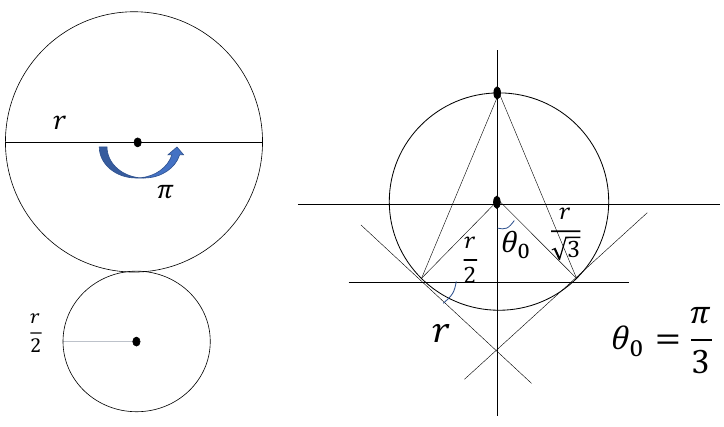
Figure 1 . The left panel shows the net of a cone cut out from T 2 = Z 2 , whereas in the right panel, p the cone cut out by T 2 = Z 2 and a section of embedded quarter of S 2 with radius r= 3 are drawn. where f j;M 0 ( z 0 ) is the holomorphic function with respect to the coordinate of CP 1 z 0 and j denotes the multiplicities of zero-modes determined by the (cid:13)ux M 0 . Here, we use the same index label j as in the T 2 = Z case in order to smoothly connect the S 2 and T 2 = Z 2 2 wavefunctions in the blow-down limit r ! 0 as shown in the following analysis. The but the (cid:13)ux is shifted to M 0 ! M 0 + 1 due to the curvature of S 2 . (That is, the